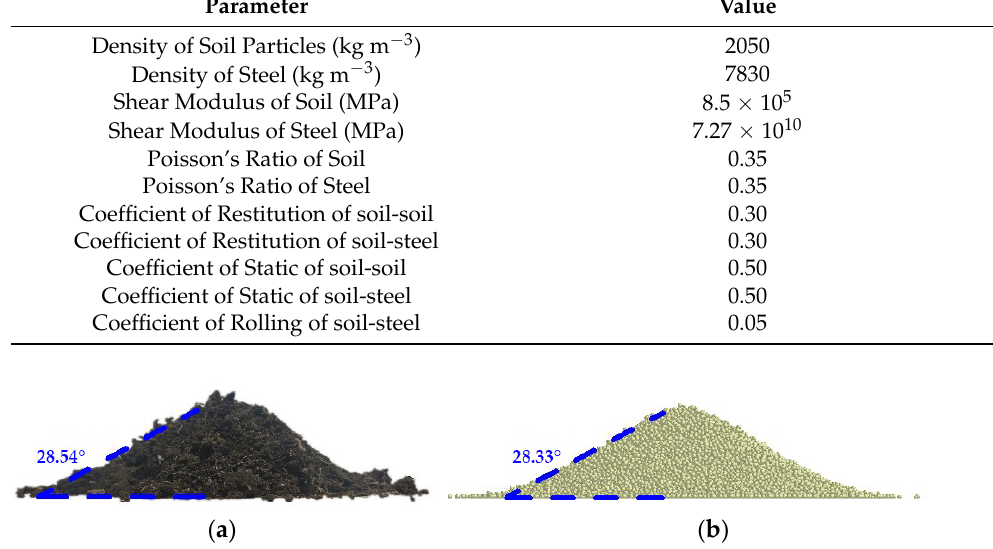
Figure 5. Calibration of soil rest angle. ( a ) Image in the laboratory; ( b ) Image in the discrete element simulation test. Table 5. Simulation parameters of the discrete element simulation test.